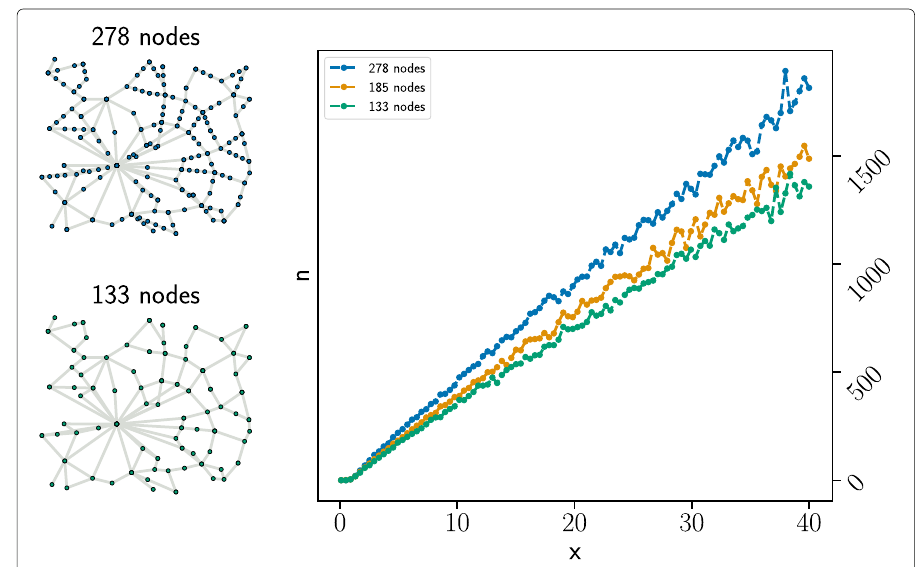
Fig. 6 Ride-sharing efficiency depends also on network size, in addition to topology. The slope of n vs. x differs between a few street networks created by differently coarse-graining the street network of Berlin. a and b shows two differently coarse-grained and hence, differently-sized networks. c n vs. x for these two